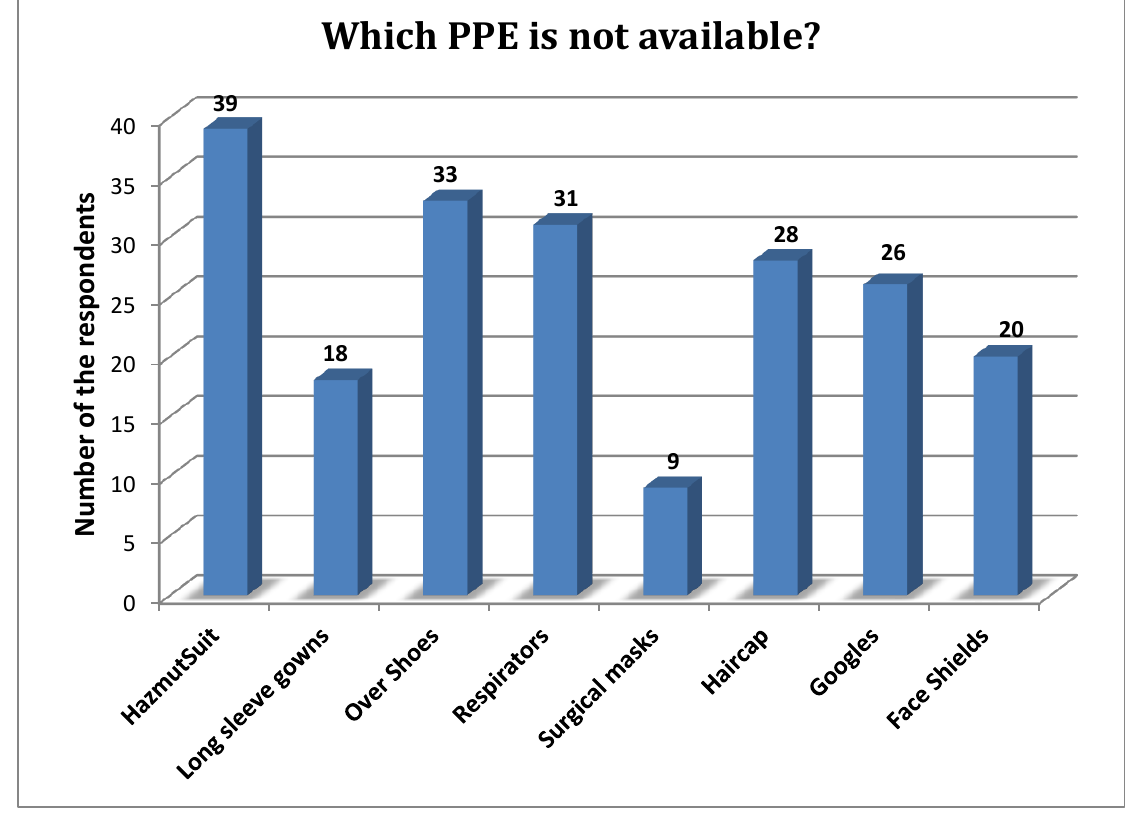
Figure 2. Bar chart showing which PPE is not available.